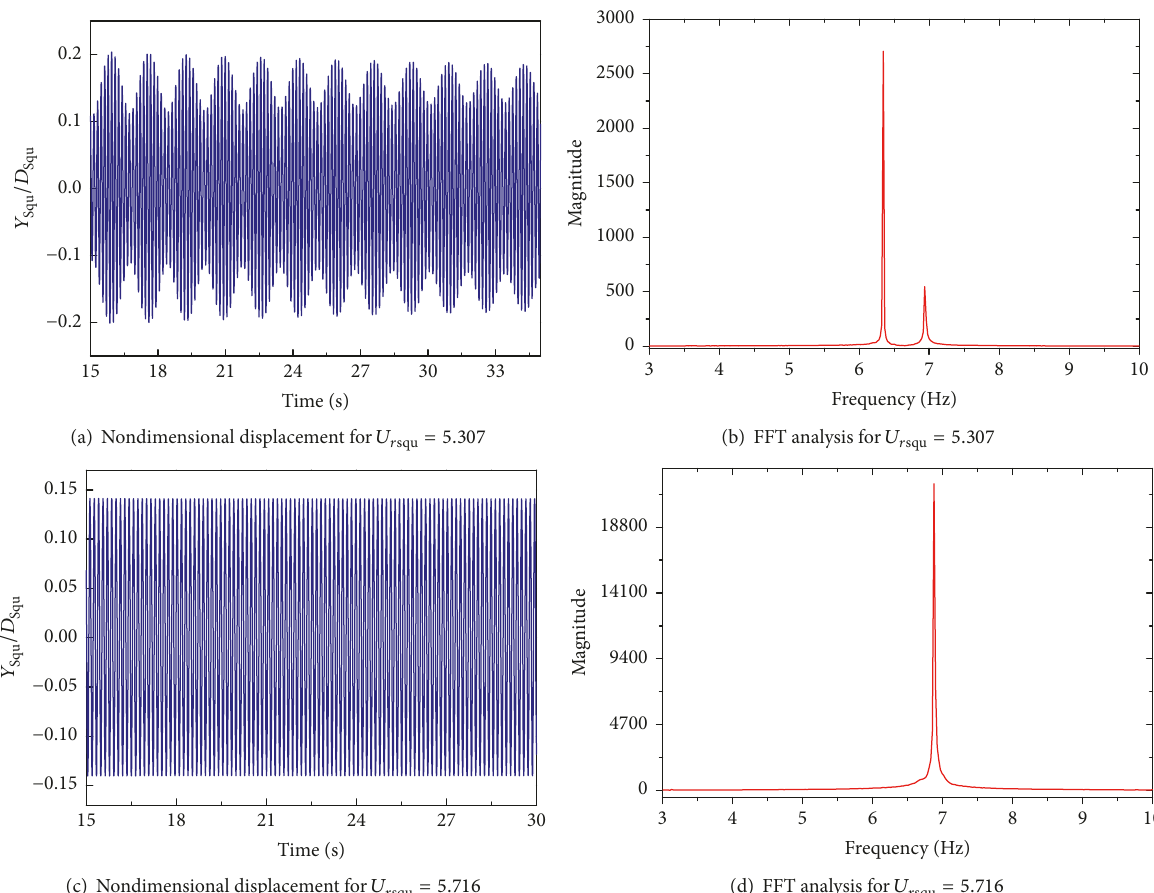
(d) FFT analysis for 𝑈 𝑟 squ = 5.716